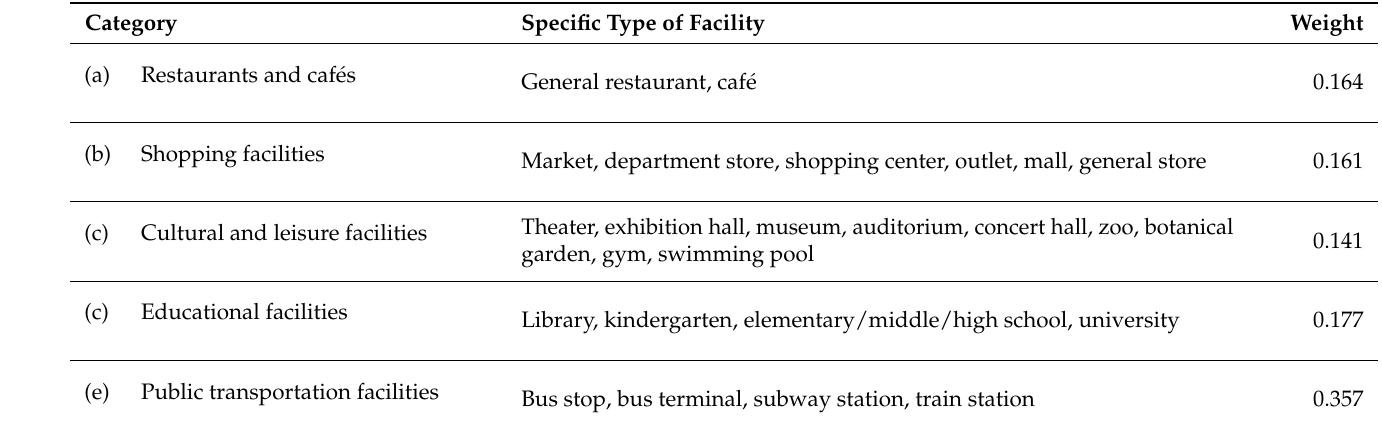
Table 1. Type and weight of pedestrian-friendly